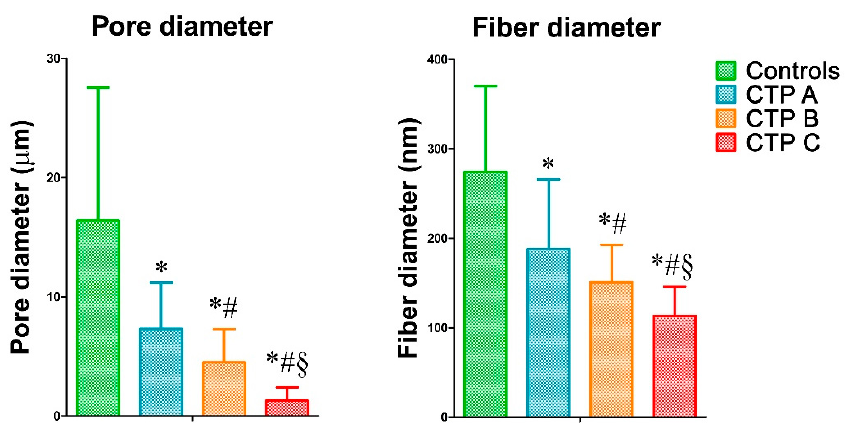
Figure 6. STED super-resolution microscopy analysis of fibrin gels of fibrinogen purified from patients with liver cirrhosis at di ff erent disease severity ( n = 5 for each Child–Turcotte–Pugh category) and controls. STED super-resolved microscopy revealed a marked increase in fiber density and clot porosity in fibrin from cirrhotic patient when compared to controls. Leica Application Suite X Software analysis demonstrated that fibrin fibers from fibrinogen purified from cirrhotic patients showed a significant decrease in fiber diameter and clot porosity when compared to controls, and this became more marked with disease progression. Values are represented as mean ± SD. * Significant di ff erence vs. controls at the p < 0.05 level. # Significant di ff erence vs. CTP A at the p < 0.05 level. § Significant di ff erence